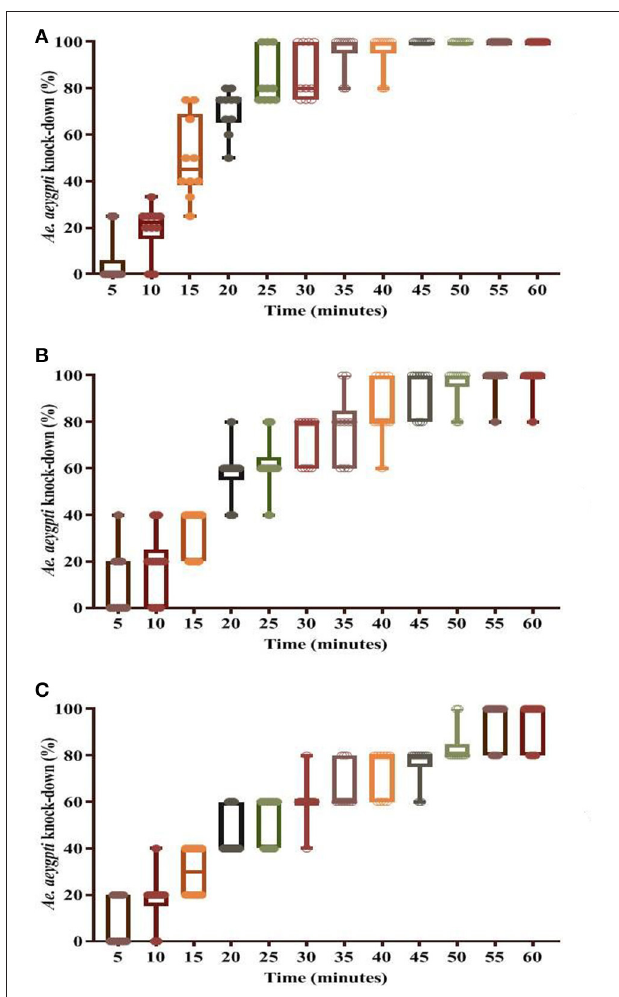
FIGURE 6 | Knockdown rate in dengue vector Ae. aegypti using insecticidal paint formulation (WSRIP-3). (A) after 6 months (T6); (B) after 12 months (T12); (C) after 18 months (T18).